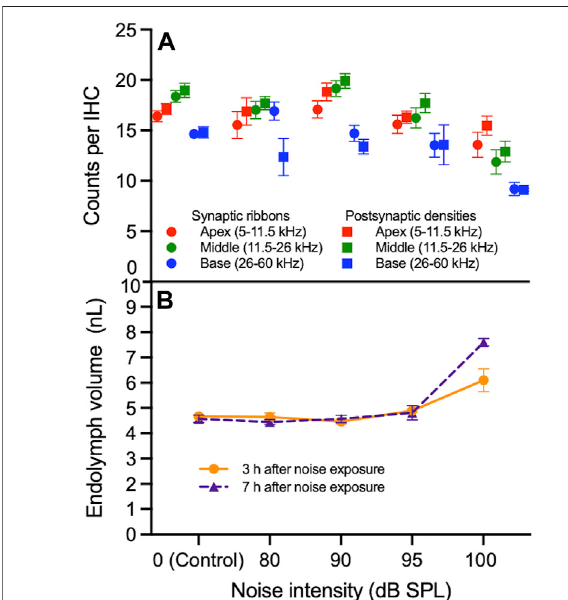
FIGURE 3 | Correlation between synapse loss and endolymphatic hydrops as a function of noise intensity. (A) The numbers of synaptic ribbons and postsynaptic densities (PSDs) per inner hair cell (IHC) in the apex, middle and base of the cochlea do not progressively decrease between 0 (control) and 95 decibel (dB) sound pressure level (SPL) noise exposure. Between 95 and 100 dB SPL noise exposure, ribbons and PSDs per IHC decrease inthemiddle andbase ofthecochlea moresharplythanintheapex. (B) Endolymph volume is relatively stable between 0 and 95 dB SPL at 3 and 7 h after noise exposure. Between 95 and 100 dB SPL noise exposure, endolymph volume increases; this increase is sharpest 7 h after noise exposure. Data points represent means and error bars indicate standard error. All ribbon and PSD counts per IHC represent averages of both the right and left ears when available. Endolymph volume represents the volume of the scala media over a segment of basement membrane that is 150 μ m in length.